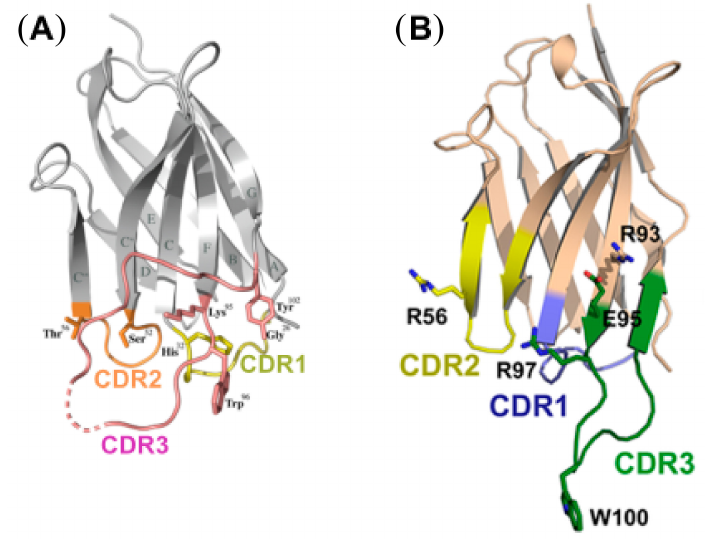
Figure 4. Crystal structures of anti-HIV-1 nanobodies. ( A ) Ribbon representation of CD4bs VHH D7; the complementarity determining regions (CDR) are highlighted in yellow (CDR1), orange (CDR2), and pink (CDR3). The side chain of tryptophan Trp96 on CDR3 is critical for gp120 interaction and neutralization. The dotted line indicates CDR3 residues without su ffi cient resolution. Reproduced with permission from Hinz et al. [39]. ( B ) Ribbon representation of membrane proximal envelope region (MPER) region nanobody 2H10. The CDR loops are colored blue (CDR1), yellow (CDR2), and green (CDR3). The hydrophobic tryptophan residue at the tip of the long CDR3 loop is not required for binding to gp41 but is essential for orientation in the lipid envelope of the virus and for weak neutralization activity; much stronger neutralization resulted by ligating two 2H10 VHH via a glycine-serine linker. Reproduced with permission from Lutje Hulsik et al.